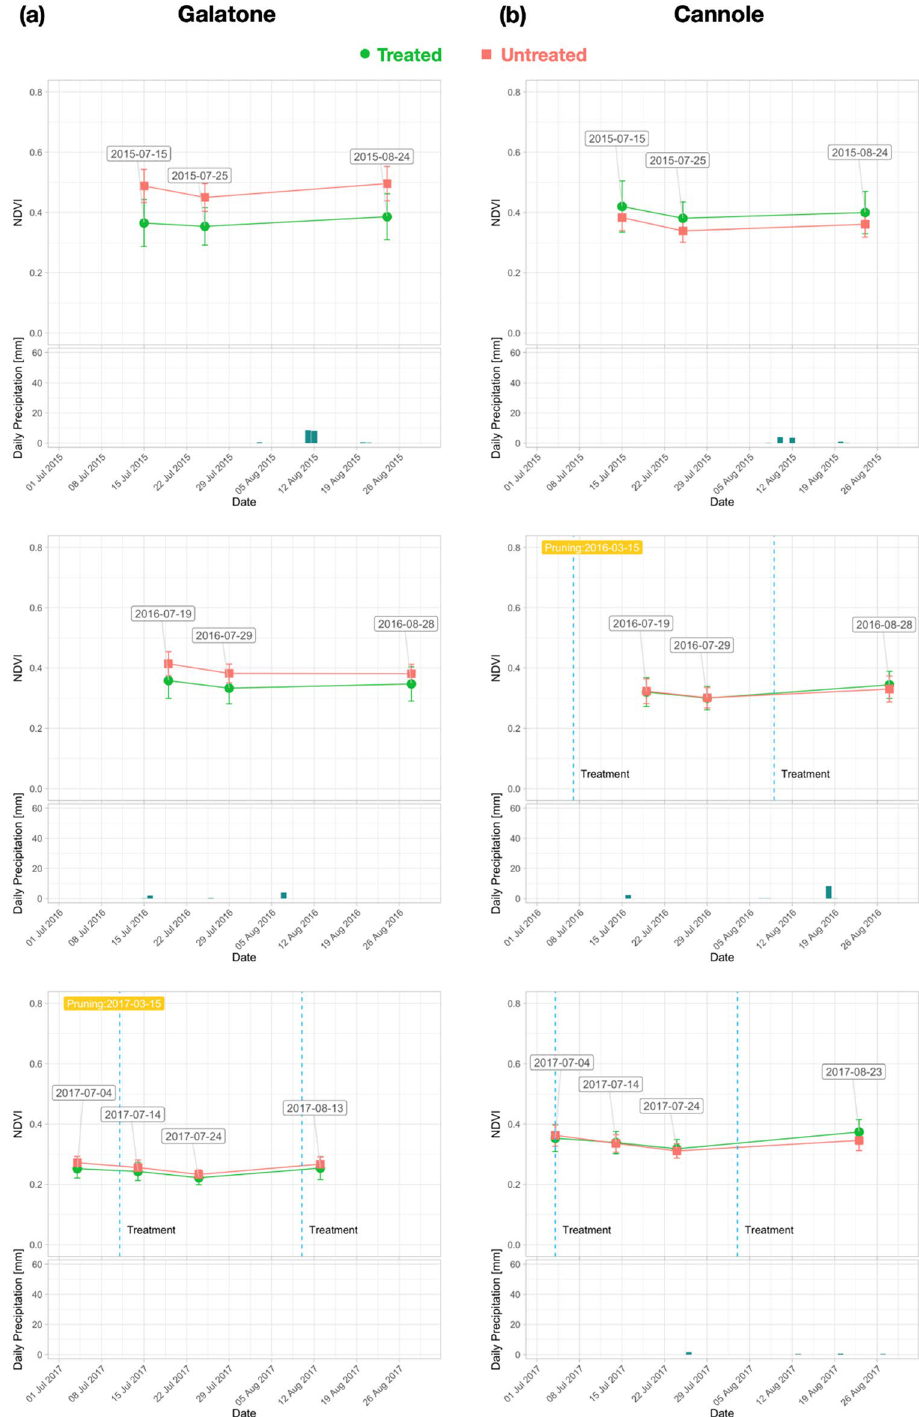
Figure 6. NDVI trend for each year (2015–2017) from S-2 date: ( a ) Galatone; ( b )